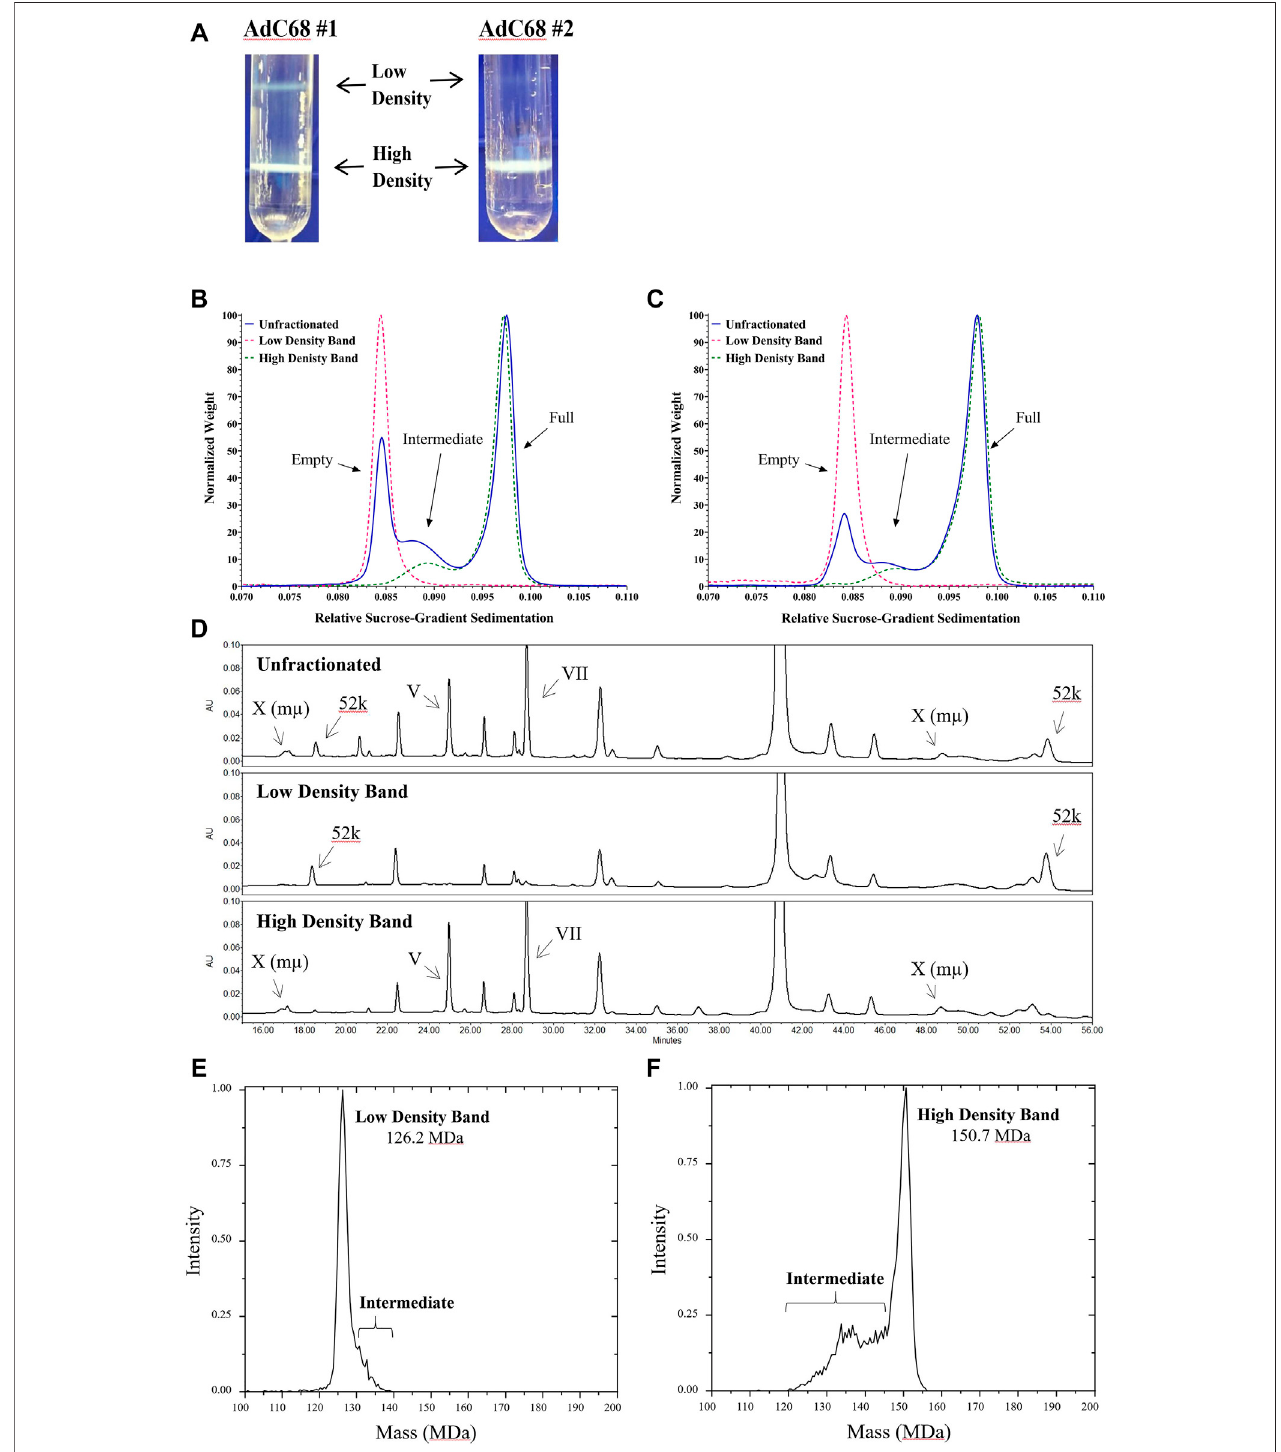
FIGURE 2 | Analysis ofpreparative ultracentrifugation bands for AdC68 #1 and #2. Panel A isa representative picture of the CsCl preparative fractionation. Panels BandCareDCSoverlaysoftheunfractionatedandlow/highdensityfractionsforAdC68#1and#2,respectively.PanelDisaReversedPhasedHighPerformanceLiquid Chromatography stacked-plot of the proteome content for AdC68 #1 unfractionated and low density/high density fractions. Panel E and Panel F are Charge Detection Mass Spectrometry spectra of the AdC68 #1 low/high density fractions showing the experimentally determined molecular masses, respectively.